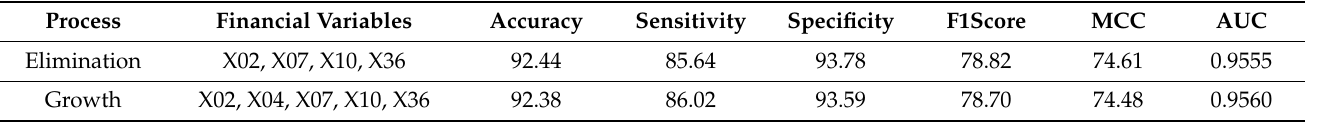
Table 8. The results-based second elimination and growth